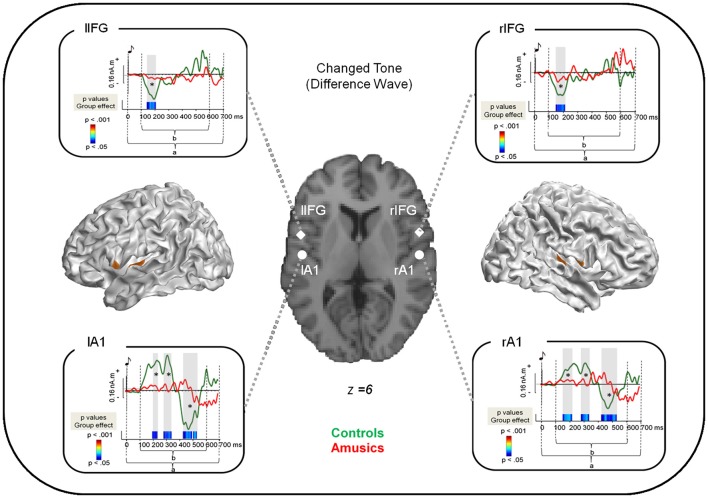
Source reconstruction of the brain responses specifically evoked by the changed tone in S2. Cortical meshes show bilateral regions that were significantly different from baseline (as indicated by the brown areas). Coordinates of the peaks of activations are displayed on the single subject T1 image provided by SPM8 for four regions: the bilateral auditory cortices as well as the bilateral pars opercularis of the Inferior Frontal Gyrus (see Table 2). The surrounding panels correspond to the grand average of source data for each region and for the time window where the inversion was performed (0–700 ms after the changed tone onset, as indicated by a) for the control group (green) and the amusic group (red). Two sample t-tests were performed at each time sample and for each region on source amplitude in the 100–600 ms time window (as indicated by b) in the two groups of participants. p-values are reported across time below the source amplitudes with blue for p < 0.05; green for p < 0.01; and red for p < 0.001. Note that only effects lasting longer than 15 ms were reported. See Albouy et al., 2013a for details.